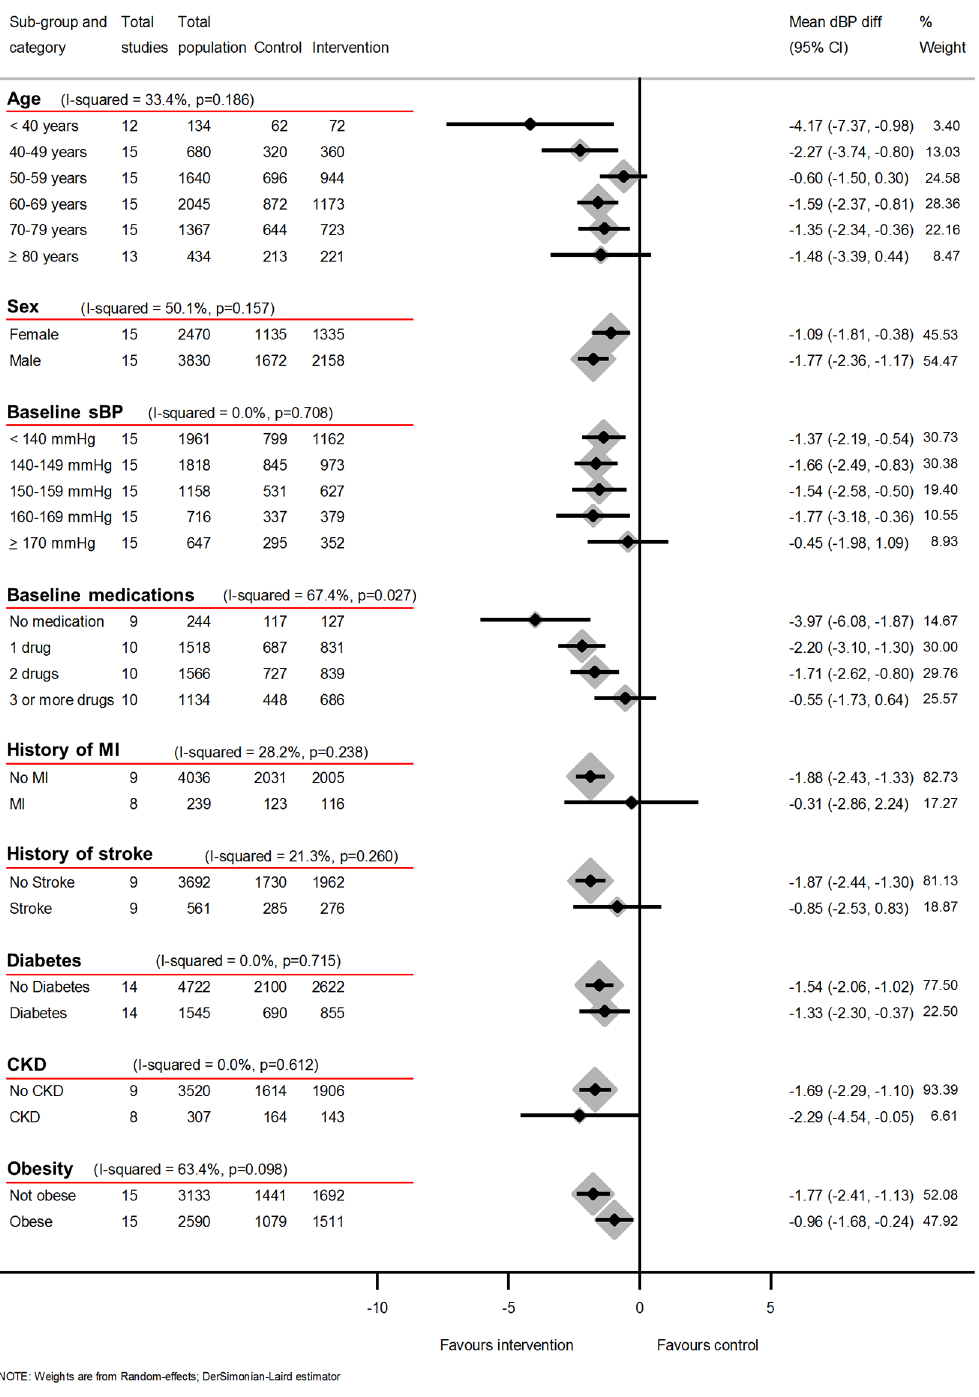
PLOS Medicine| https://doi.org/10.1371/journal.pmed.1002389 September 19,